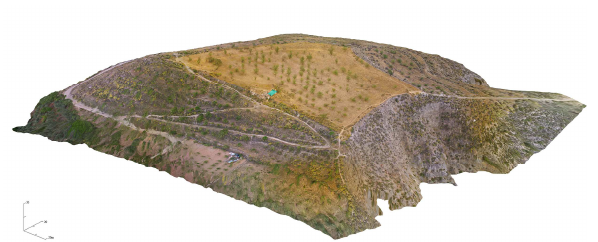
Figure 6. Photogrammetric model of the fortress of Dúrcal.